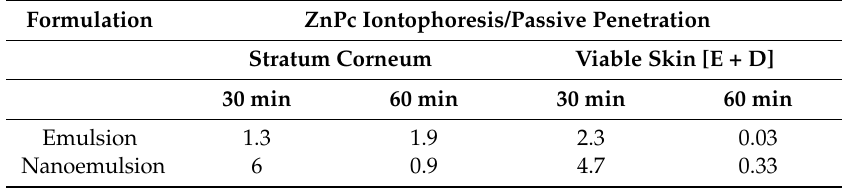
Table 4. Ratio between ZnPc recovered from the skin after iontophoresis and passive